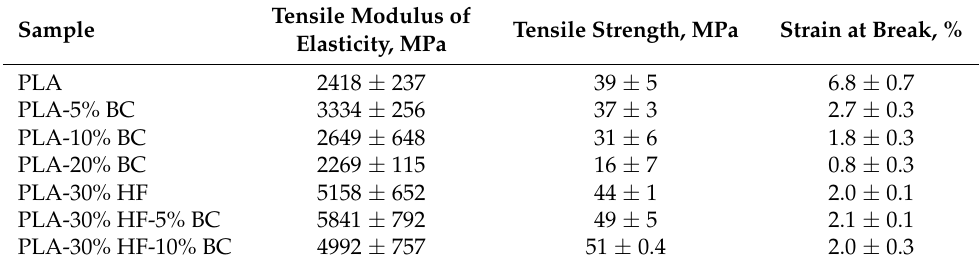
Figure 2. Stress-strain plots of PLA-based composites. Table 4. Tensile properties of the PLA-based composite